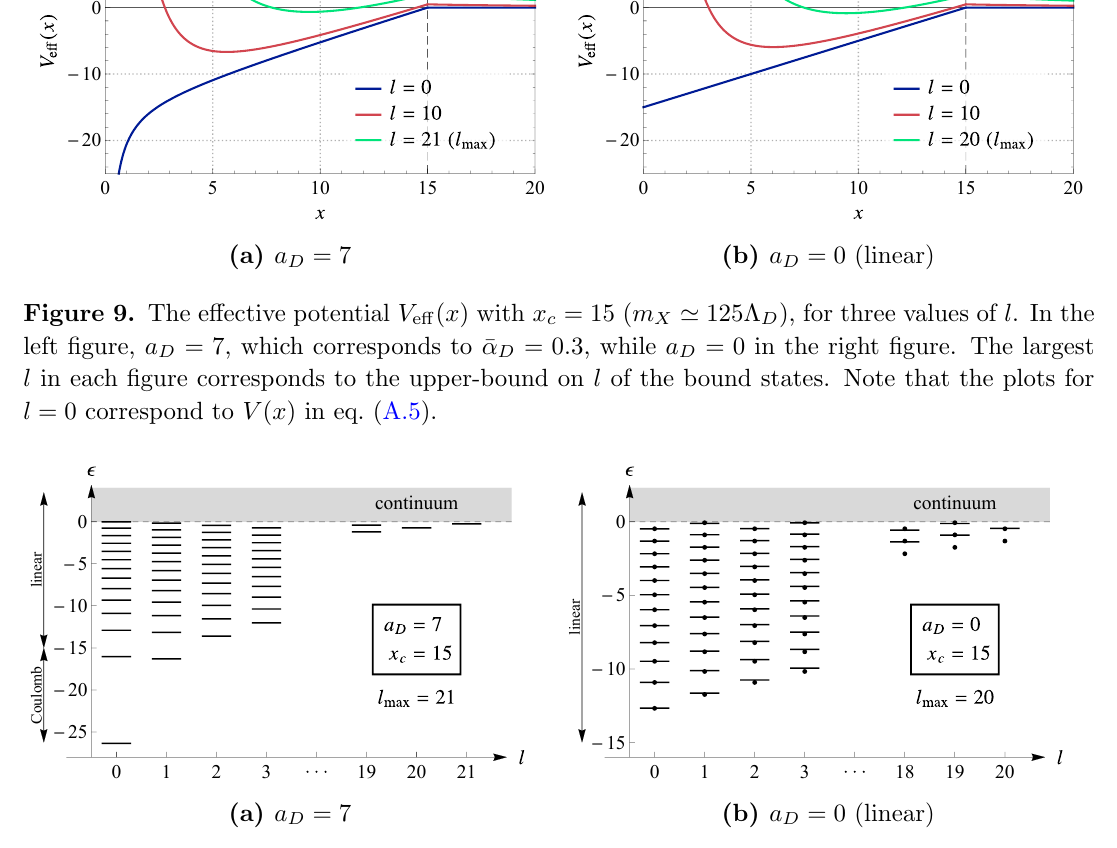
Figure 10. The energy spectrum of bound states. We also show, for the linear potential, the semiclassical results in eq. (A.8) as the small